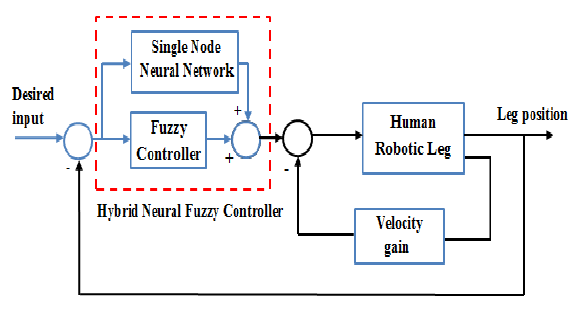
Fig. 4. The block diagram for hybrid neural fuzzy controller for human robotic leg